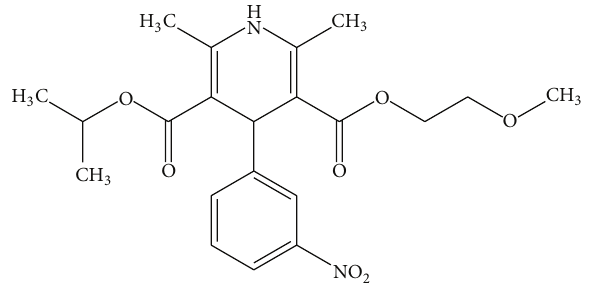
Figure 1: Chemical structure of nimodipine.